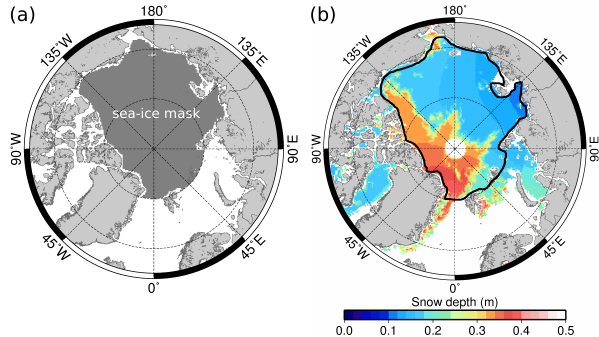
Figure 5. (a) Data mask, which is applied to calculate sea-ice thick- ness estimates. Only thickness data within the dark grey area are considered as valid. (b) Snow depth from March 2011 and data mask (solid black line). Thickness data in excluded regions are dis- carded because the W99 snow-depth fit is not valid